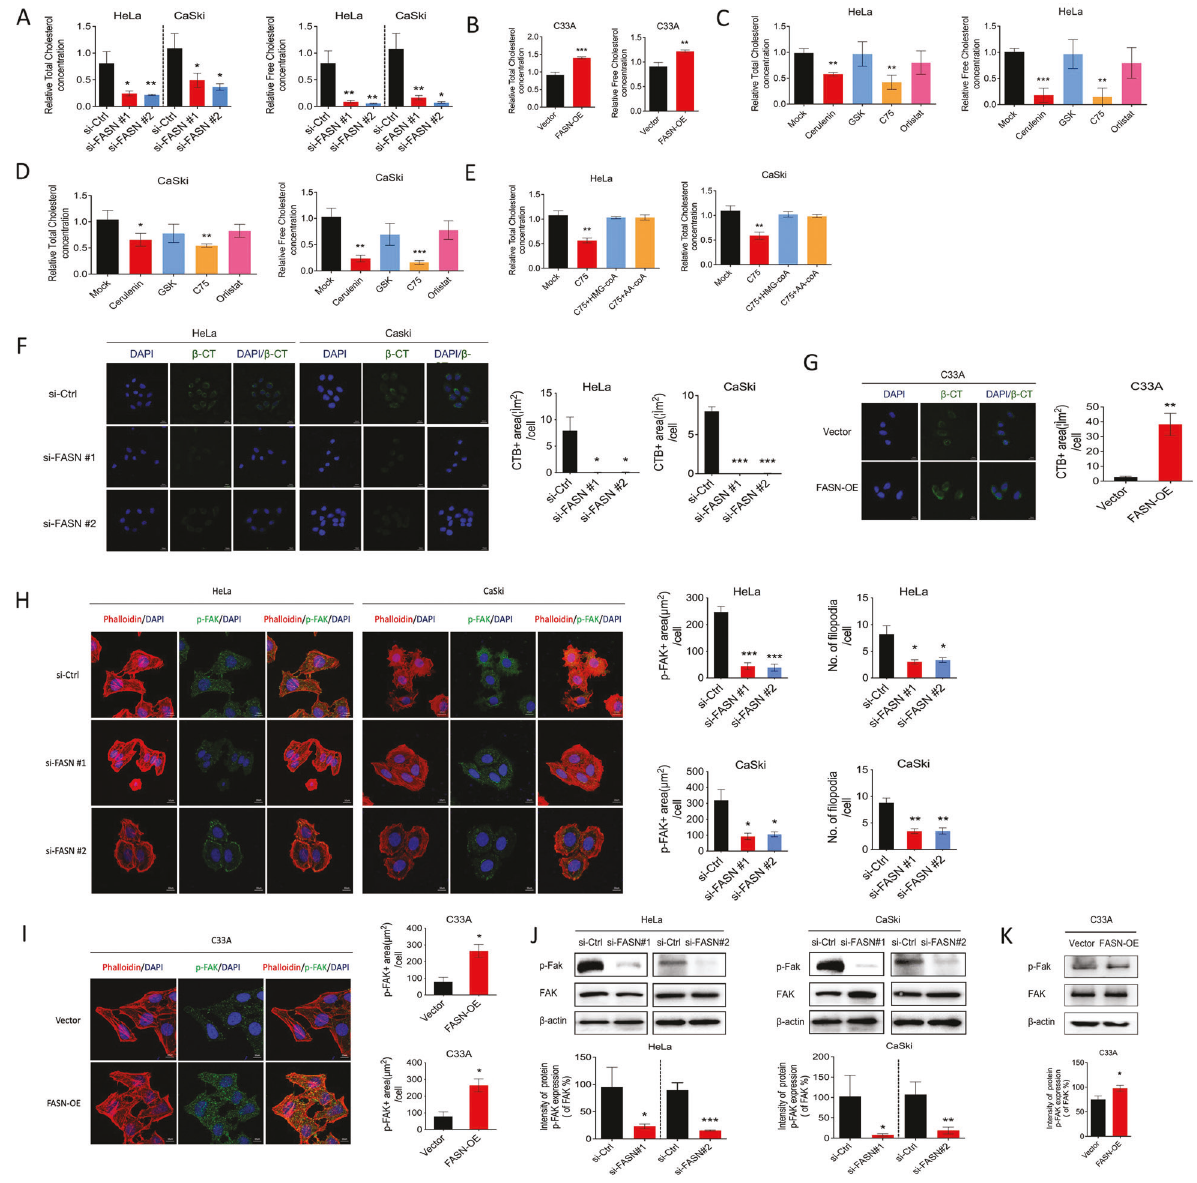
Fig. 4 FASN regulates cholesterol reprogramming, consequently leading to lipid rafts and actin skeleton remodeling. A Assessment of total and free cholesterol concentration in si-FASN (FASN siRNA#1 and #2) and si-Ctrl groups of the HeLa and CaSki cells. B Total and free cholesterol concentration in C33A-vector and C33A-FASN-OE groups. C , D Assessment of total and free cholesterol concentration in the HeLa and CaSki cells treated with different FASN inhibitors (Cerulenin, GSK, C75 and Orlistat). E Total cholesterol concentration in the HeLa and CaSki cells treated with Mock, C75, C75 + HMG-coA, C75 + AA-coA. F , G Lipid raft staining images and corresponding positive areas were analyzed in the same settings in A , B . H F-actin and phospho-FAK IF staining is shown, and p-FAK positivity and the number of fi lopodia were quanti fi ed in si-FASN (FASN siRNA #1 and #2) and si-Ctrl groups of HeLa and CaSki cells. I F-actin and phospho-FAK IF staining, quanti fi cation of p-FAK + area and fi lopodia number were indicated in C33A-vector and C33A-FASN-OE groups. J , K Western immunoblot analysis of p-FAK, FAK, and β -actin after FASN knockdown (siRNA#1 and #2) and FASN overexpression (FASN-OE). * P < 0.05; ** P < 0.01; *** P <